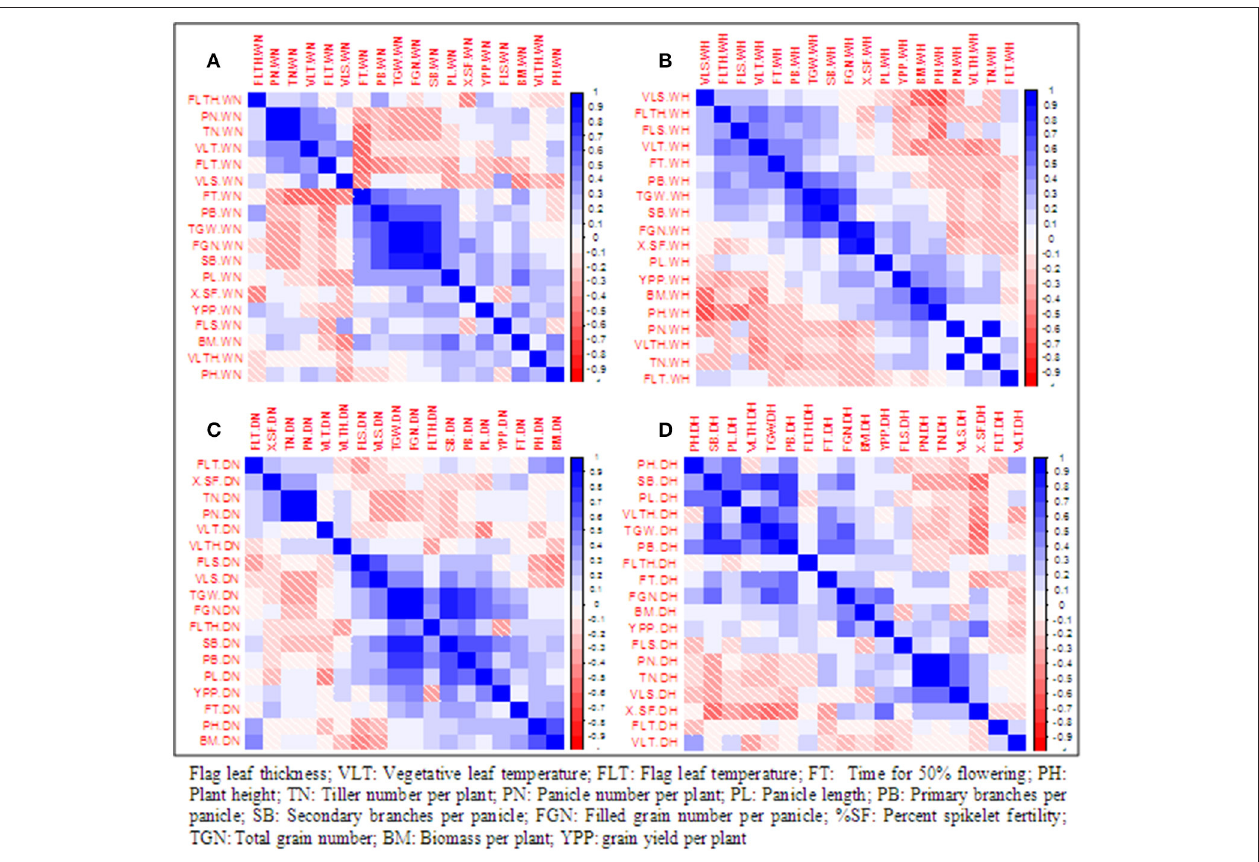
FIGURE 1 | Pearson correlation among 18 traits under normal conditions and polycover house /late sown conditions during wet season 2012 and dry season 2013. (A) WN, Wet season normal; (B) WH, wet season heat stress; (C) DN, Dry season normal; (D) DH, Dry season heat